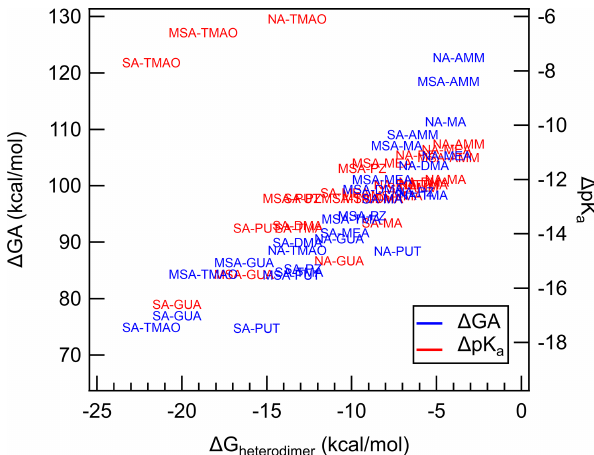
Figure 4. Calculated (cid:49) GA and (cid:49) p K a plotted against (cid:49)G heterodimer . Each data point represents an acid–base pair between either SA, NA or MSA with either AMM, MA, DMA, TMA, TMAO, GUA, MEA, PUT or PZ. Blue text represents (cid:49) GA values, while red text represents (cid:49) p K a values. Text markers are centered over the data